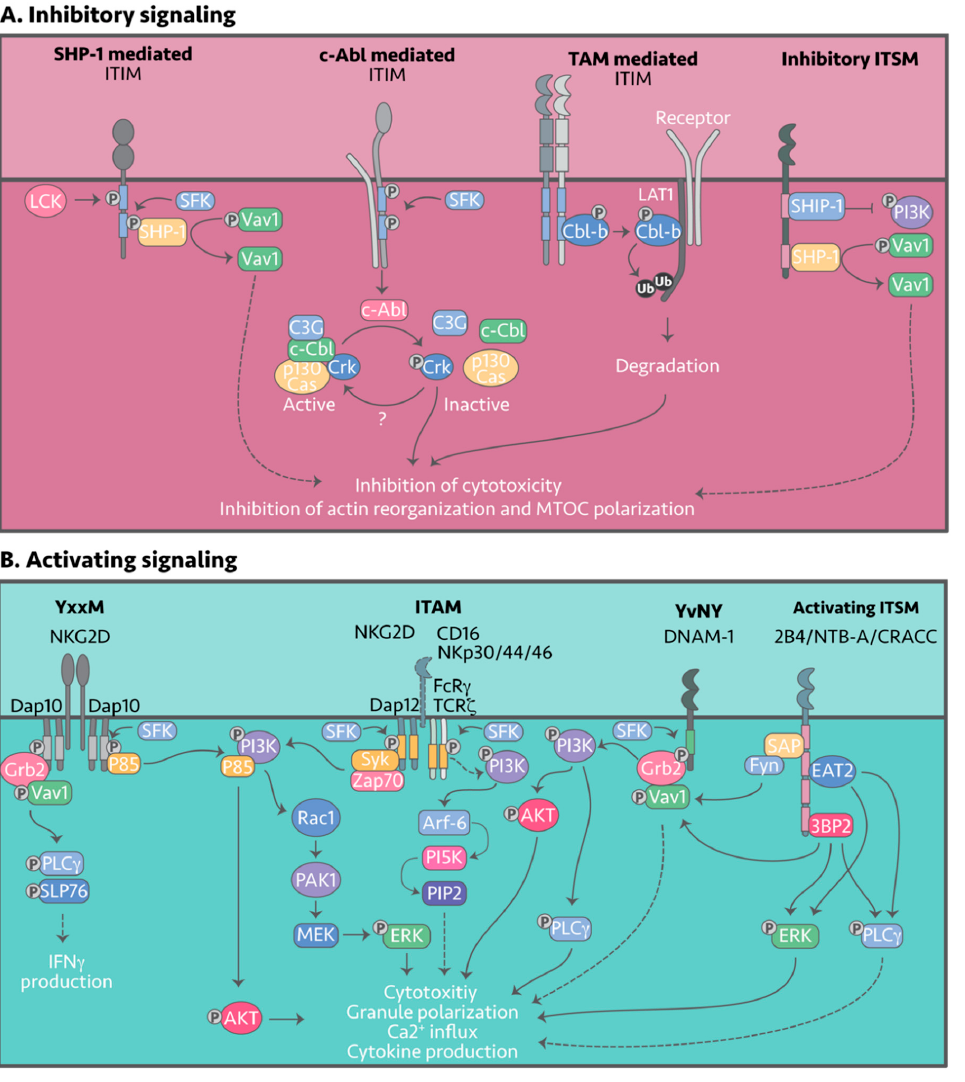
Figure 3. Inhibitory and activating NK cell signaling. NK cell effector function is collectively determined by the strongest activating or inhibitory signals. ( A ) Signaling downstream of inhibitory receptors is initiated by ligand engagement, followed by tyrosine phosphorylation of the signaling motif by Src-family kinases (SFK), Fyn or Lck. Once phosphorylated, there are three known inhibitory